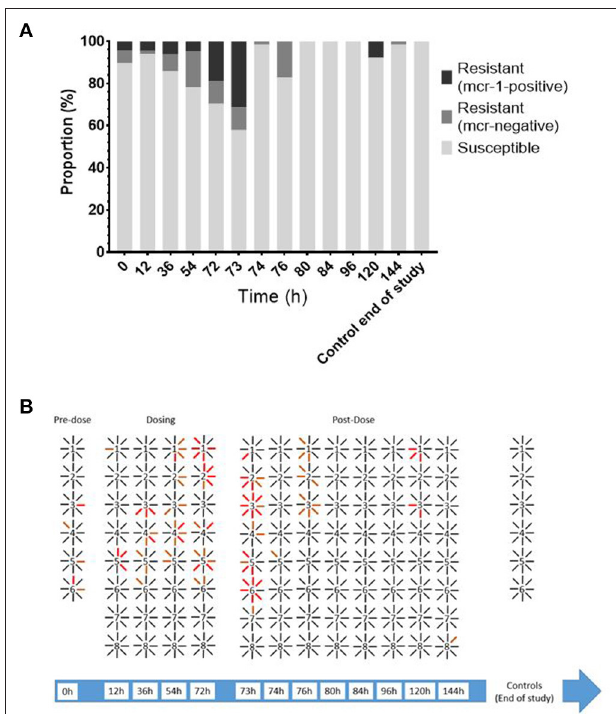
FIGURE 4 | (A) Proportion of E. coli isolates from LIC [ n = 48 (0, 12, 36, and 54h) or 64 (72h onward)] susceptible, resistant (MIC ≥ 2 mg/l), and mcr-1-positive isolates over time. (B) Filiation between bird (number) and individual isolates recovered (lines). Black line = susceptible; orange line = resistant mcr-negative; red line = resistant